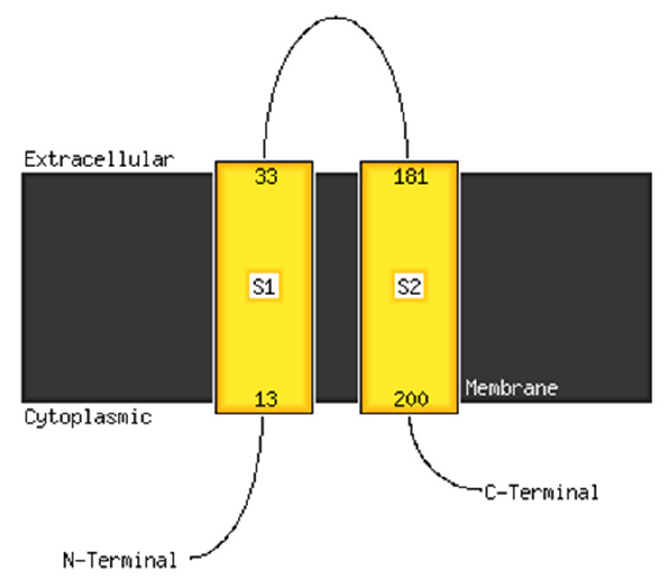
Figure 7. Membrane localization of VicK (WalK) of E. faecium NCIMB10415 using the PSIPred server. An extracellular motif is revealed between the amino acid 33 and 181, which may represent the domain binding catecholamines.